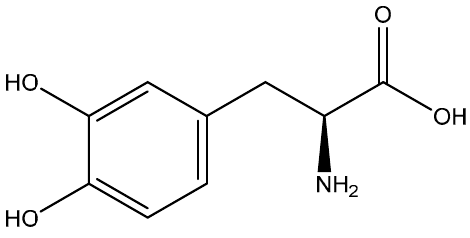
l -3,4-dihydroxyphenylalanine ( l Figure 1. The chemical structure of L -3,4-dihydroxyphenylalanine ( L -DOPA) . Figure 1. The chemical structure of